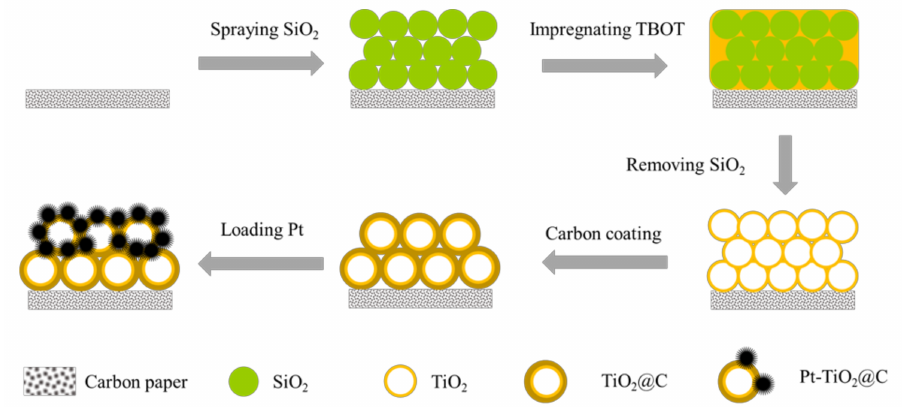
Figure 1. Schematic diagram for preparation of the porous Pt-TiO 2 @C array